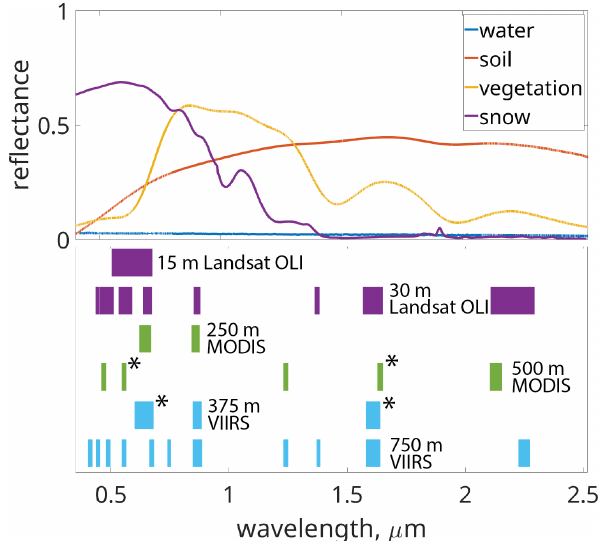
Figure 2. Hyperspectral measurements of common land surfaces: average Alfisol soil, Pinus vegetation, and water spectra (Meerdink et al., 2019; Baldridge et al., 2009) along with a typical dirty moun- tain snowpack from Mammoth Mountain, CA, on 1 May 2021. The lower panel shows the bands and spatial resolutions corresponding to the satellite sensors used in this study. The black asterisks de- note the NDSI bands, while the spectral-unmixing approaches use all bands to map